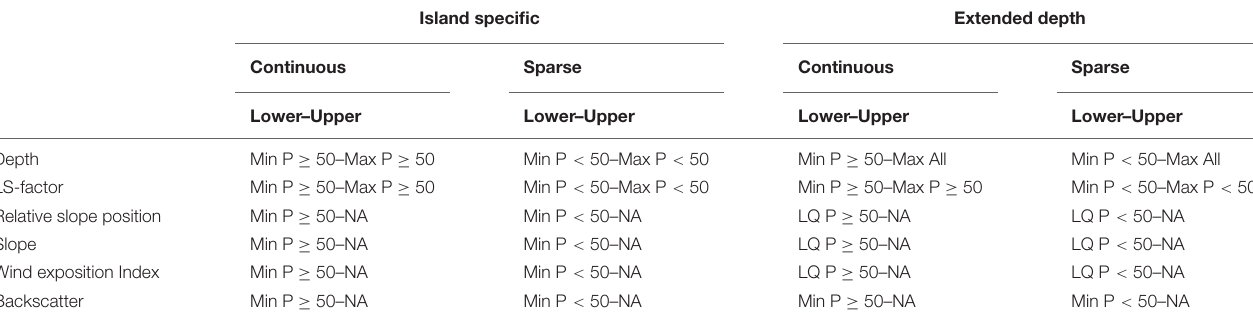
TABLE 2 | Summary of the environmental envelope decision rules with lower and upper boundaries used to create the maps depicting island-specific suitable habitat and potentially suitable habitat in deeper water for VME indicator taxa observed occurring as continuous habitat (bottlebrush and whip corals and sponges, > 50% of images per object) and the sparse branching corals observed only occasionally ( < 50% of images per